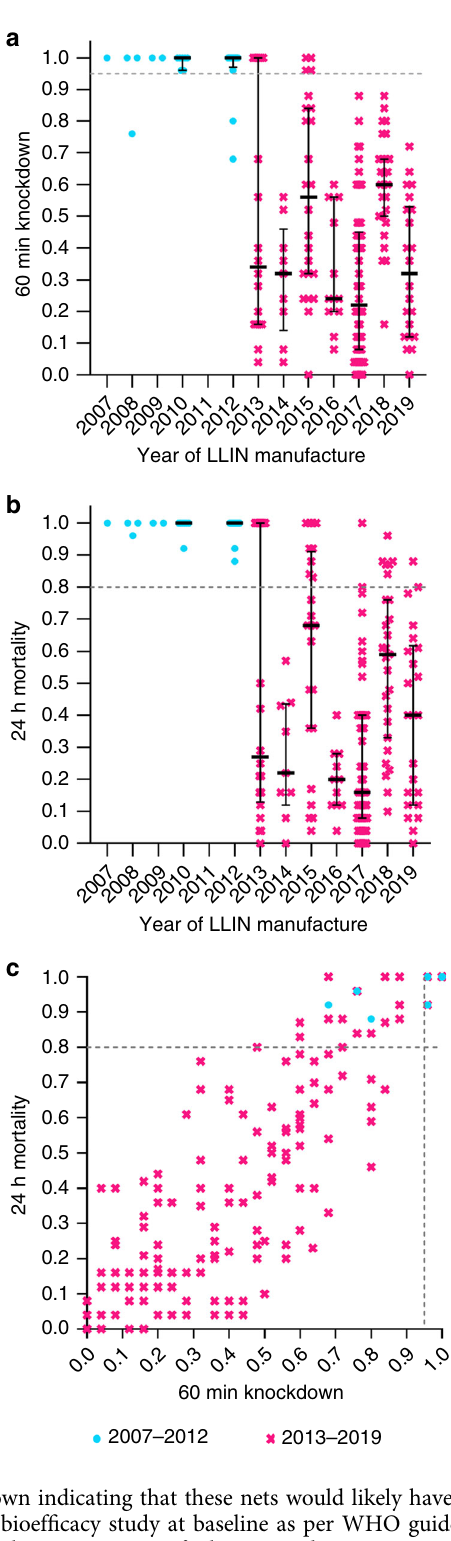
knockdown indicating that these nets would likely have passed a phase 3 bioef fi cacy study at baseline as per WHO guidelines 23 .